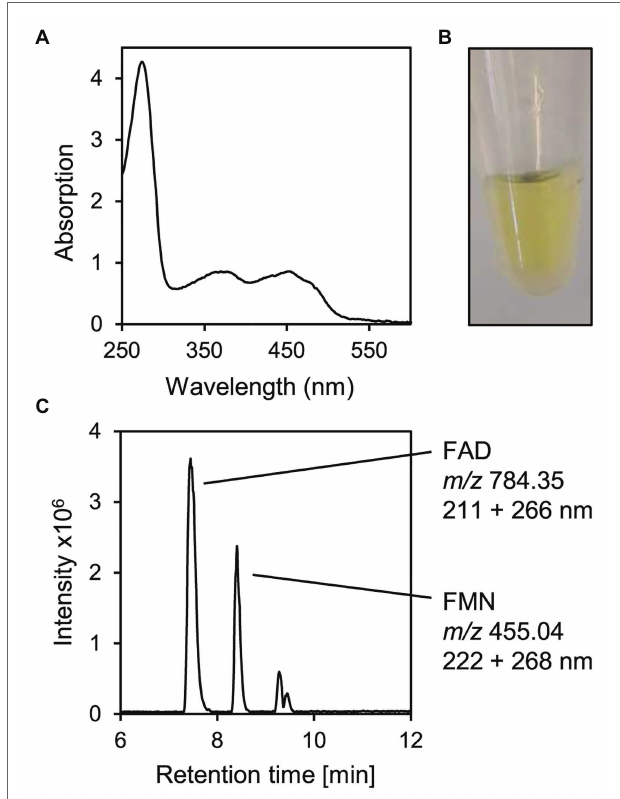
FIGURE 4 | Characteristics of purified 5 β - Δ 4 -KSTD1. (A) UV/VIS- Absorbance spectrum. (B) Yellow-colored solution of purified 2.48 mg ml −1 5 β - Δ 4 -KSTD1. (C) MS base peak chromatogram of the supernatant of 5 β - Δ 4 - KSTD1 denatured with 50% methanol indicating FAD and FMN as cofactors. During HPLC-MS measurements, absorption was measured for 200–320